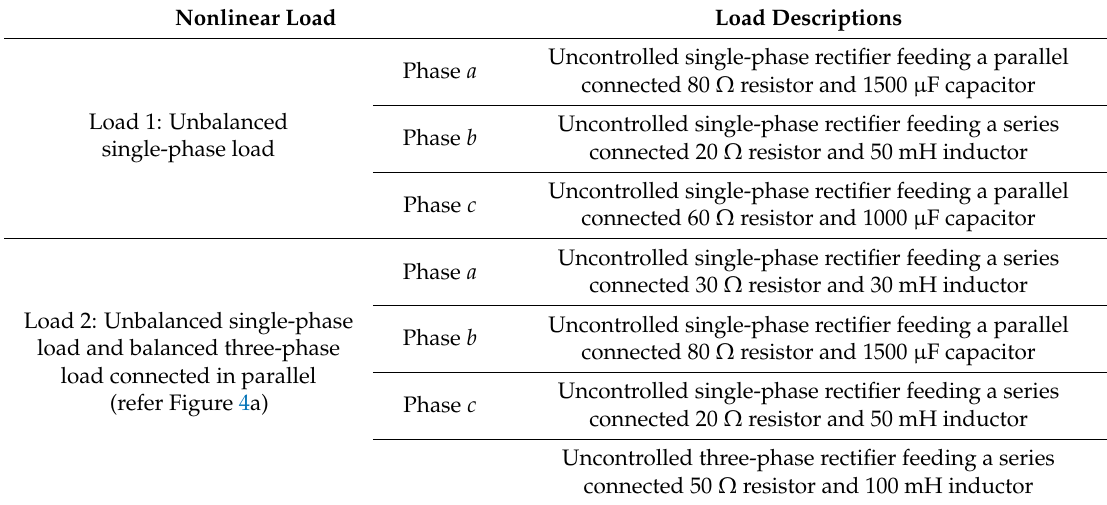
Table 1. Nonlinear load configuration for simulation